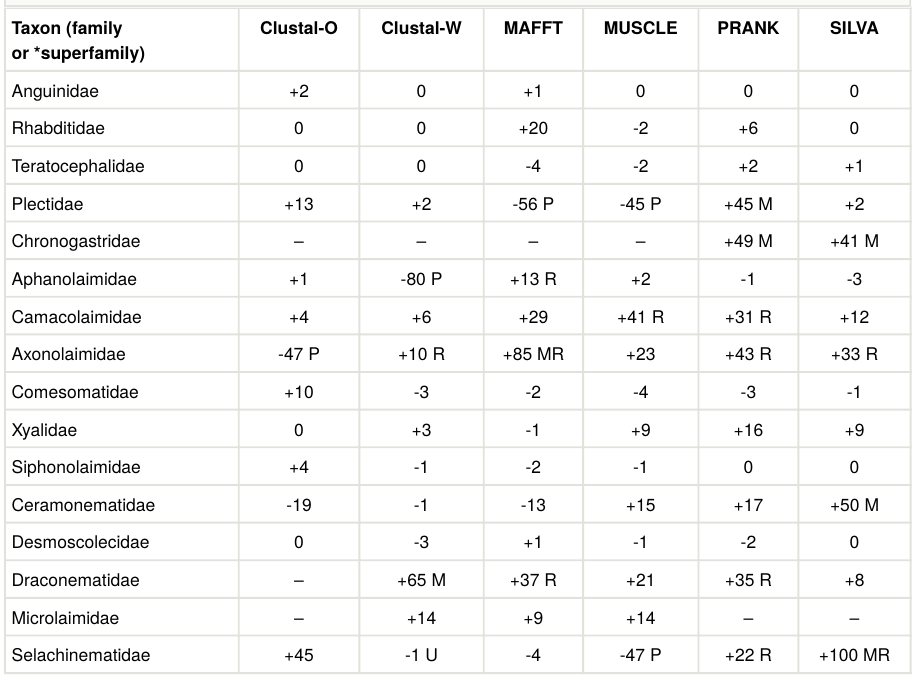
Comparison of changes in bootstrap support (increase or decrease) and resolution for di ff erent nematode families between Maximum likelihood analyses of " fi ltered" and "long" datasets. Legend: "M" – clade changed from paraphyletic or polyphyletic to monophyletic; "P" – clade changed from monophyletic to paraphyletic or polyphyletic; "–" – clade remained paraphyletic or polyphyletic; "R" – monophyletic clade became fully resolved (bootstrap increased to ≥ 70%); "U" – monophyletic clade became unresolved (bootstrap decreased to